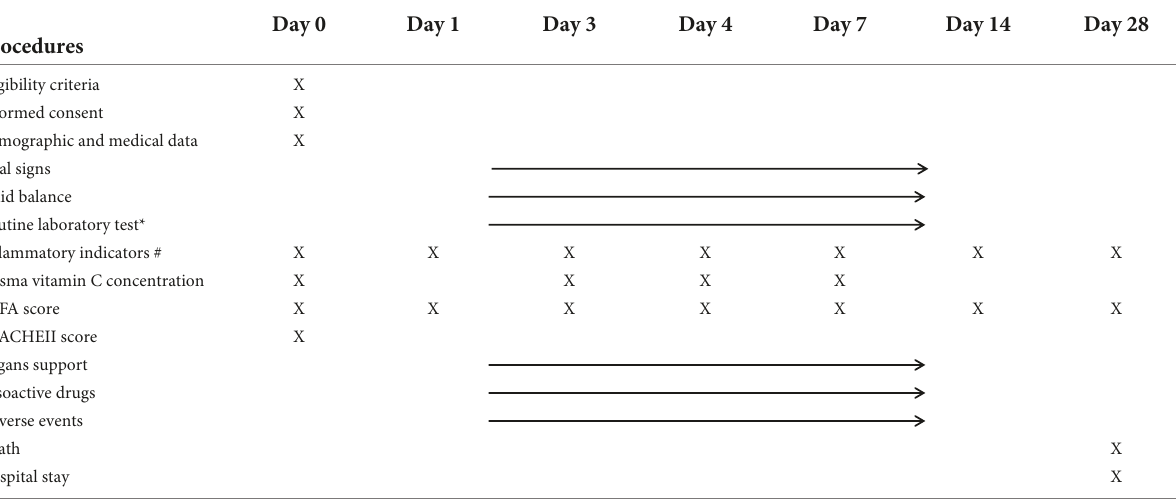
TABLE 1 Collected data and